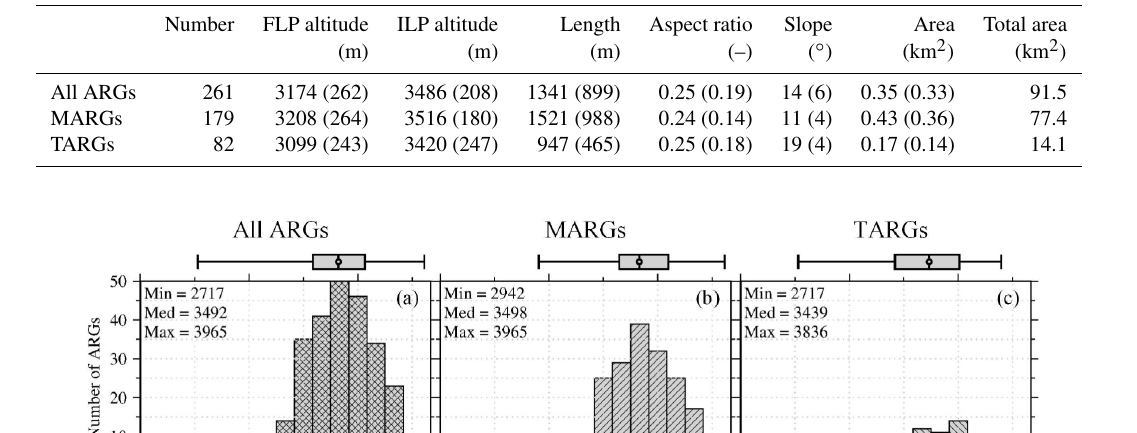
Table 2. Statistical summary of the inventoried active rock glaciers. Each column gives the mean values and the standard deviations (the values in brackets) of the parameters.